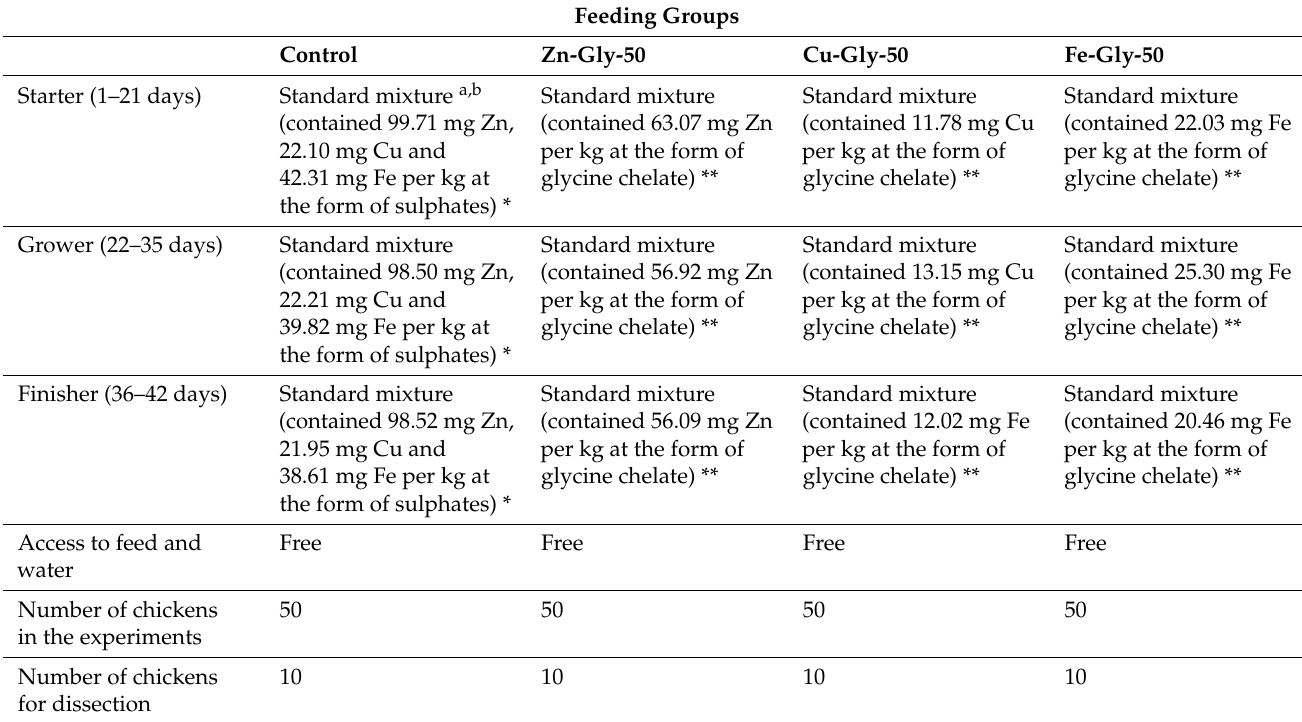
Table 1. Experimental design—treatment I (50% of the mineral in the form of chelate).